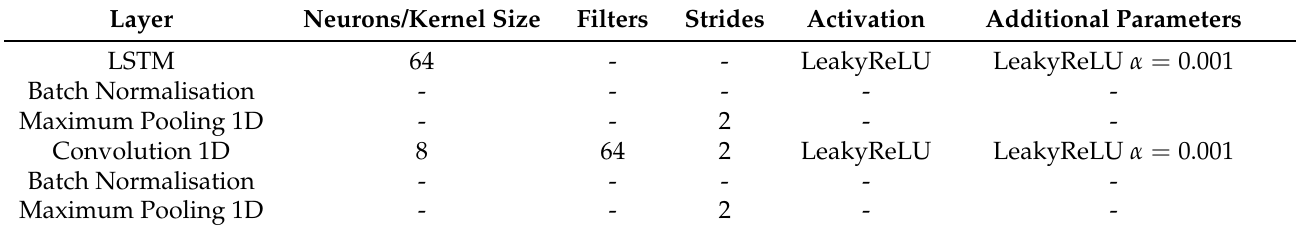
Table A1. The layer details of Block 1.